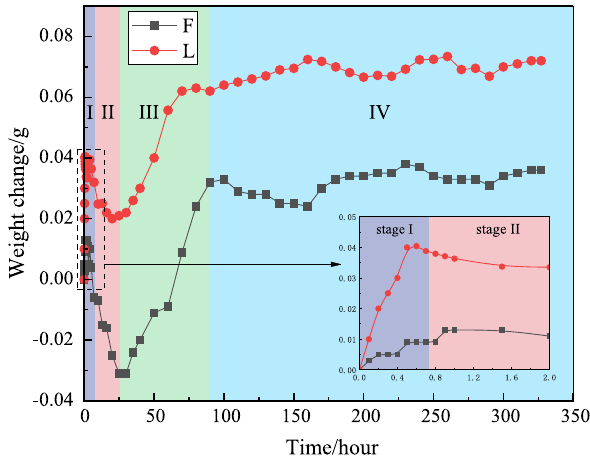
Fig. 6 SI of high-salinity slick water (18 wt% MnCl